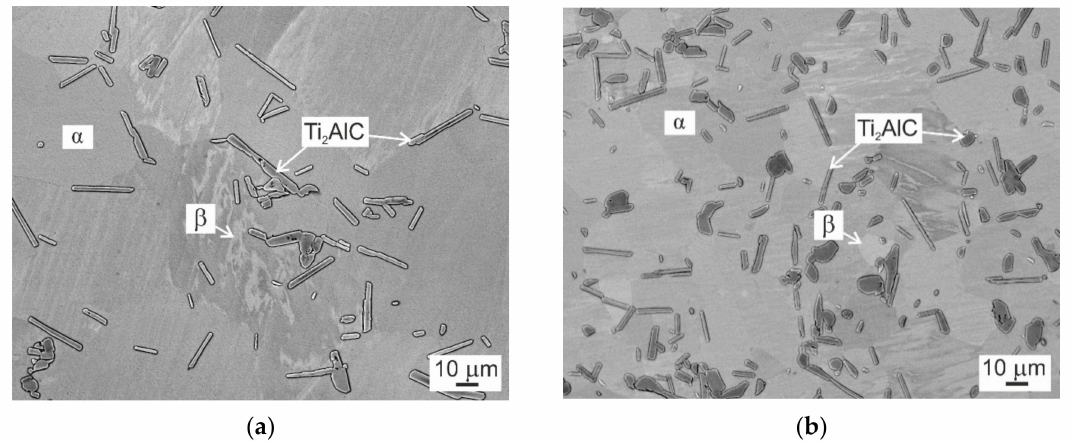
Figure 3. BSE micrographs showing the microstructure of the studied alloys after water quenching from a temperature of 1400 ◦ C: ( a ) C20 alloy; ( b ) C36